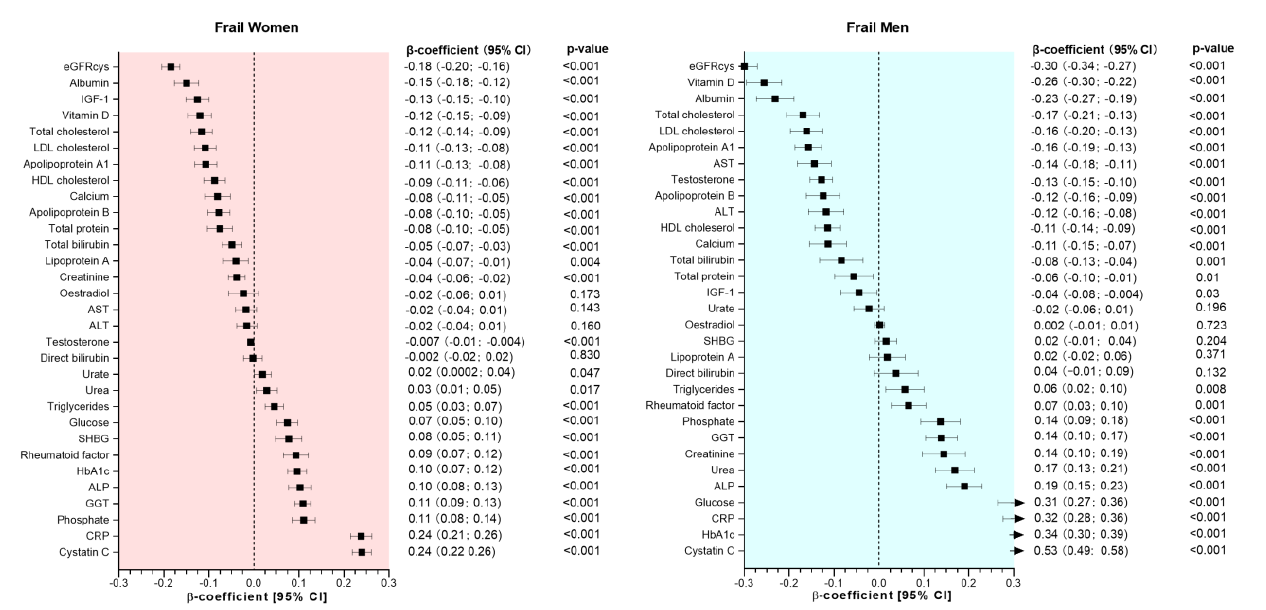
Figure 2. Association between biomarkers and frailty by sex. Data presented as β -coefficient and its 95% CI. Non-frail individuals were considered as the reference group in each case. All analyses were adjusted for age, deprivation, BMI, smoking status, sleeping time, total sedentary time, morbidity count, medication, and dietary intake (alcohol, red meat, processed meat, fruit and vegetable intake).